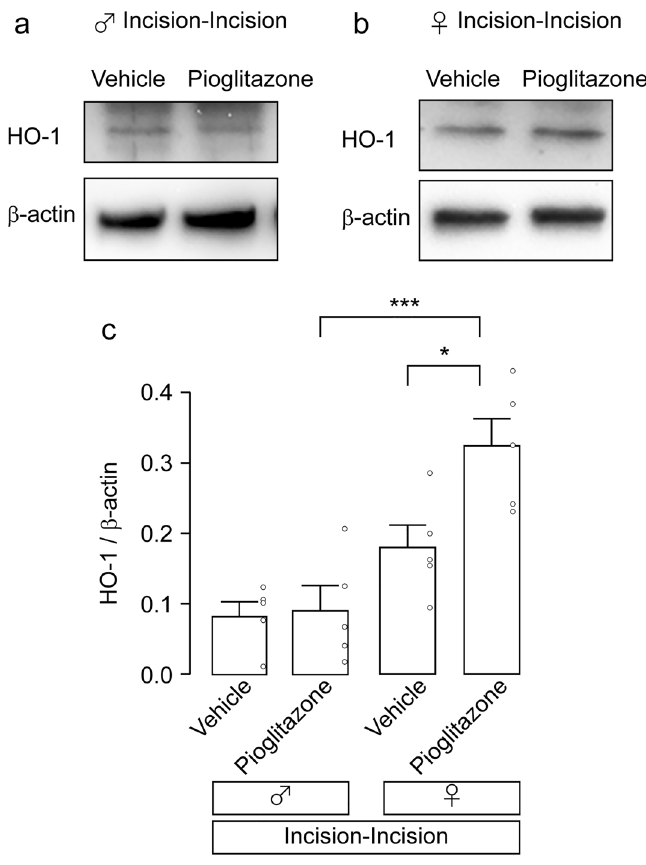
Figure 6. The effects of pioglitazone on HO-1 expression in the Vc of incision-incision rats. ( a, b ) Representative blot of HO-1 expression in the Vc of male ( a ) and female rats ( b ) 10 days after whisker pad skin re-incision. Original blots are presented in Supplementary Figs. 1 and 2. ( c ) The columns represent the average value of HO-1/β-actin. Data represent the mean ± SEM. n = 5 in each, two-way ANOVA post hoc Tukey’s test * p = 0.0271, *** p =